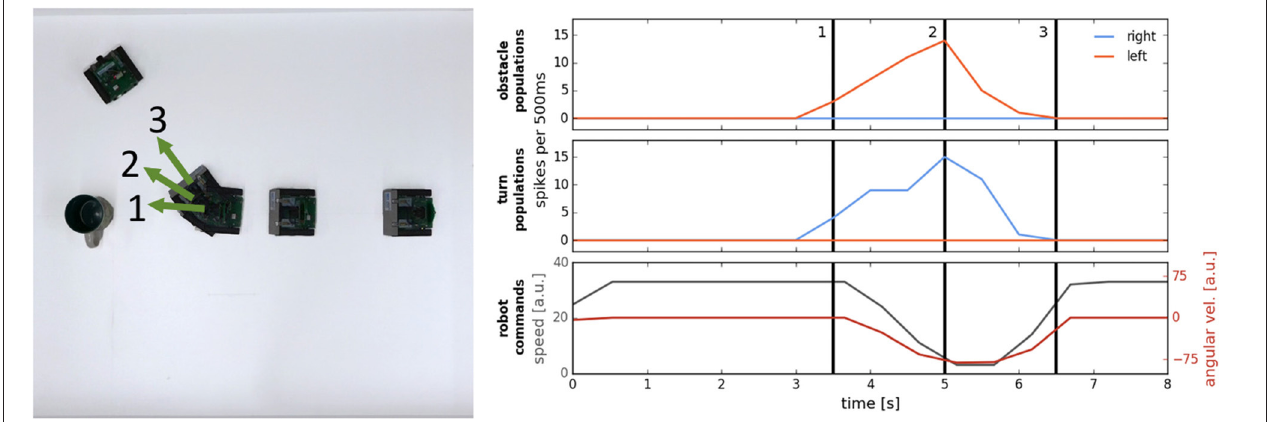
FIGURE 6 | An example of an obstacle avoidance maneuver. Left: Overlay of video frames showing the trajectory of the robot. Right: activity of the neuronal populations on the chip (Top: the left and right obstacle detecting populations; Middle: the left and right drive populations), and the motor commands, sent to the robot (Bottom plot).